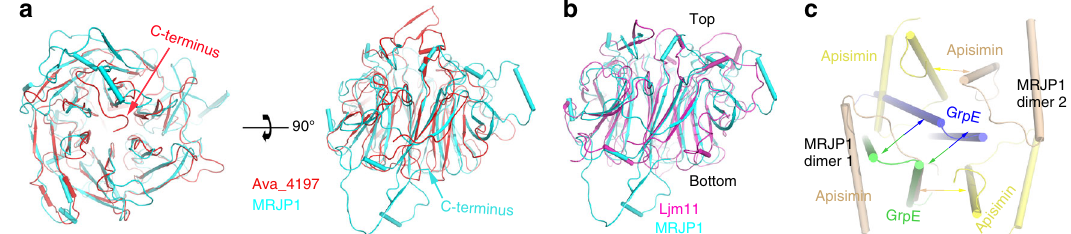
Fig. 3 Overlay of MRJP1 and apisimin with their closest structural homologs. Overlay of MRJP1 with Ava_4197 (PDB: 2qe8, a ) and Ljm11 (PDB: 3q6k, b ). c Overlay of the apisimin tetramer with the closest structural homolog, GrpE (PDB: 3a6m) 40 . Interactions between protomers are indicated